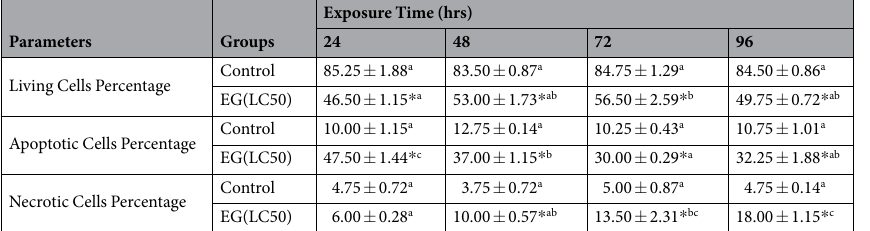
Table 6. Living cells, Apoptotic cells and Necrotic cells percentage in haemolymph of S. litura after treatment with ethyl acetate extract of S. commune . EG = Exposed group. The values represented as mean ± standard error. * Ascribes the significant difference between exposed group and control group (t-test, p ≤ 0.05). Different letters a, b, c between the columns are significantly different (Tukey’s test, p ≤ 0.05) and signify the effect of